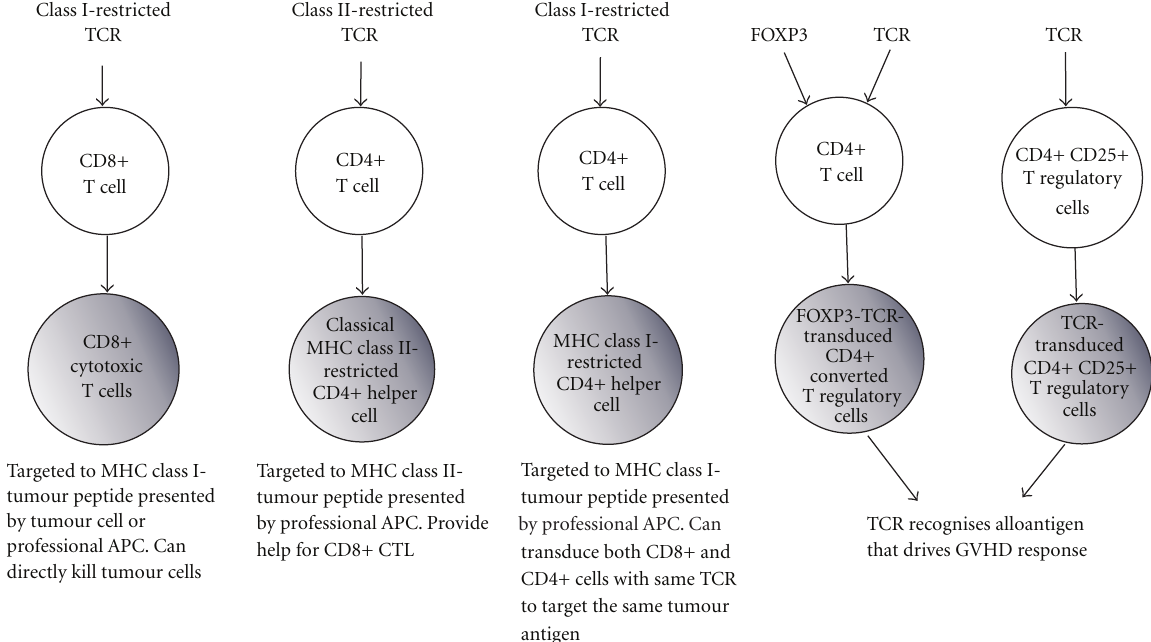
Figure 1: Populations of antigen specific T cells that can be generated by TCR gene transfer for use in adoptive immunotherapy. Retroviral gene transfer can be used to generate di ff erent populations of T cells for use in adoptive immunotherapy in the setting of haematological malignancy. Both CD8 and CD4 T cells can be transduced with class I-restricted TCR of the same specificity, targeting the same tumour antigen. Alternatively CD4 T cells can be transduced with class II-restricted TCR-specific tumour antigen presented by class II MHC. Antigen specific T regulatory cells can be generated by TCR transduction of CD4+ CD25+ T regulatory cells or CD4+ T cells can be cotransduced with TCR and FOXP3 resulting in production of antigen-specific converted CD4+ T regulatory cells. Antigen-specific T regulatory cells could be adoptively transferred in the context of HSCT or DLI to reduce harmful GvHD responses of T e ff ector cells.